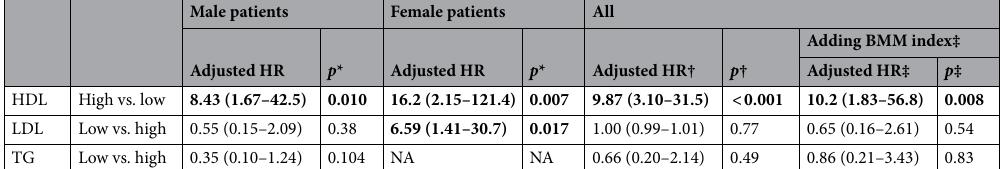
Table 2. Cox PH models. P-values are based on Cox PH models. We could not include TG in the Cox analysis of women due to the small number of events. *These models included each lipid profile (high HDL, low LDL, or low TG) , ΔALSFRS-R, ΔBMI, and %VC. † These models included age, ΔALSFRS-R, ΔBMI, bulbar type, sex, and %VC. ‡ These models included lipid profile data, BMM index, age, ΔALSFRS-R, ΔBMI, bulbar type, sex, and %VC. PH, proportional hazards; HR, hazard ratio (95% confidence interval); NA, not available; ALSFRS-R, Revised Amyotrophic Lateral Functional Rating Scale; BMI, body mass index; BMM index, BMI muscle metabolism index; VC, vital capacity; HDL, high-density lipoprotein; LDL, low-density lipoprotein; TG, triglycerides. Significant values are in